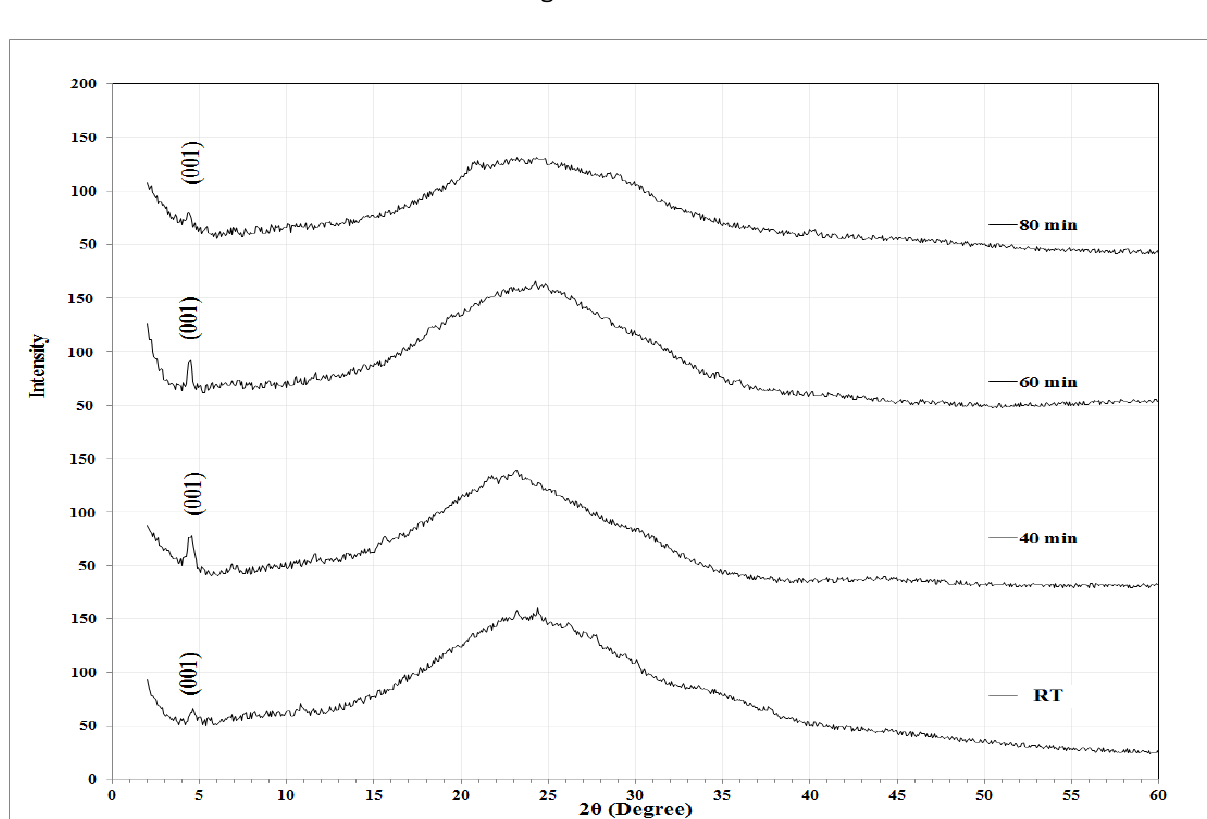
Fig. 2: XRD patterns for CuPcTs/PEDOT:PSS thin films deposited on glass substrate chemically treated with talwen at different time.